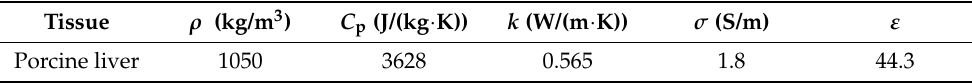
Table 2. The values of characteristic parameters of ex vivo porcine liver at 25 ◦ C.